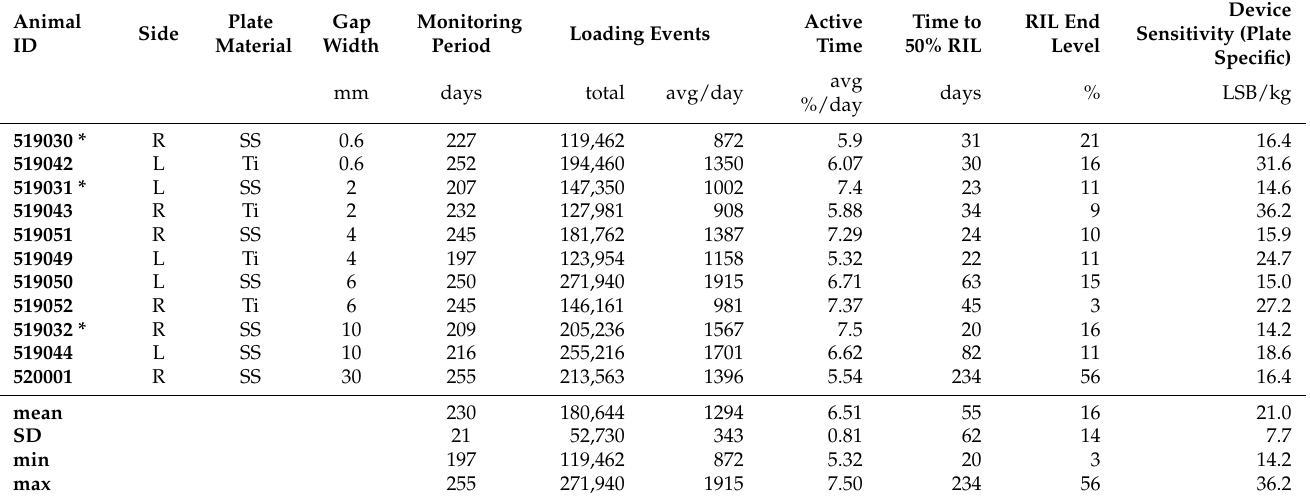
Table 1. Study parameters and outcomes. SS = Stainless Steel, Ti = Titanium, R = right, L = left, RIL = relative implant load and LSB = least significant bits. * mRUST scoring not